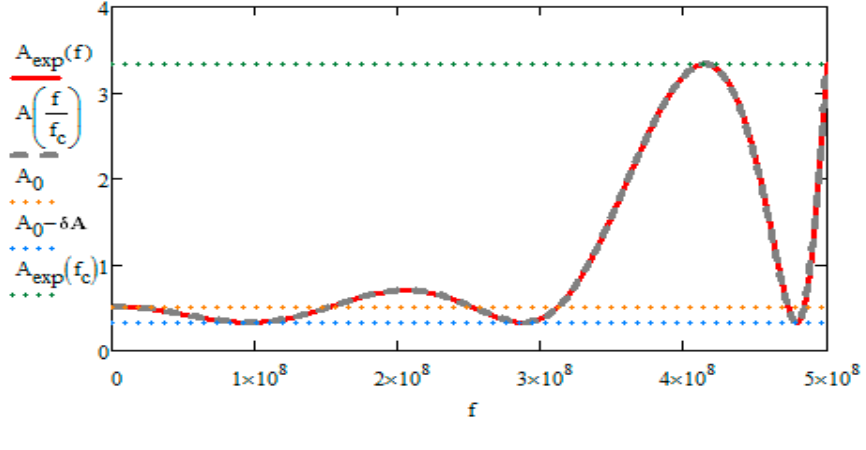
Figure 6. Passband of the Pascal Filter.